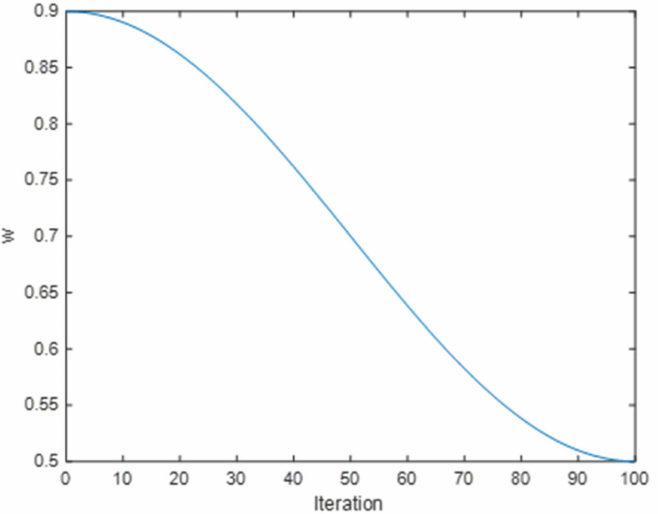
Figure 1. Inertia weight curve